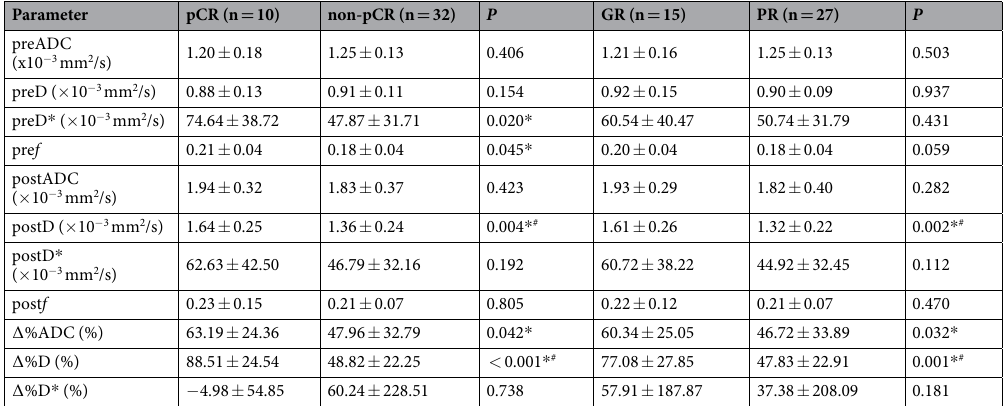
Table 3. Differences in the IVIM-DWI parametric values between the pCR and non-pCR groups and between the GR and PR groups. * Significance before multiple comparison correction; # significance after multiple comparison correction ( P [2] = 0.004 < i * q/m = 2 * 0.05/12 = 0.0083 for the comparisons between the pCR and non-pCR groups, and P [2] = 0.002 < i * q/m = 2 * 0.05/12 = 0.0083 for the comparisons between the GR and